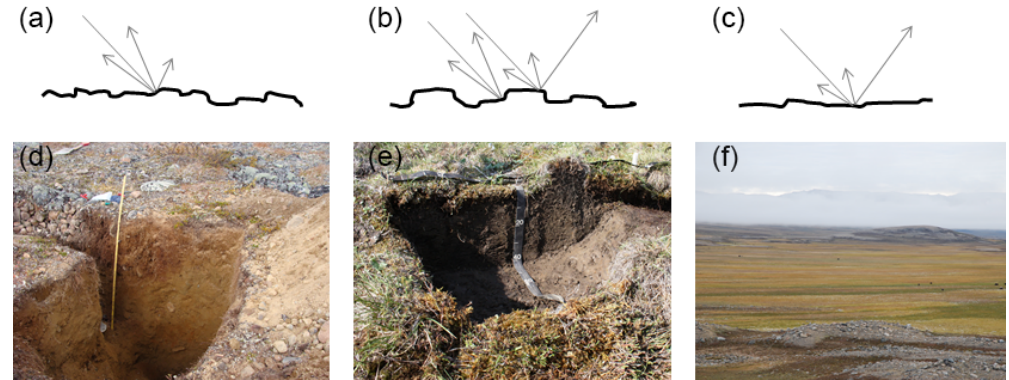
Figure 2. Top: sketch of scattering from different surfaces. The length of the arrows represents the backscatter intensity: left – rough surface with, for example, pebbles at the surface; middle – surface with partial high and low signal return; right – smooth surface with almost specular reflection (adapted from ESA 2004). Bottom: photographs (G. Hugelius) representing different roughness and soil carbon types: left – soil pit in carbon-poor landscape; middle: hummocky carbon-rich soil profile across the active layer of a frost boil; right: carbon-poor slope in the front and carbon-rich valley in the background (Zackenberg). Table 1. Available SOC data upscaled from high-resolution remotely sensed